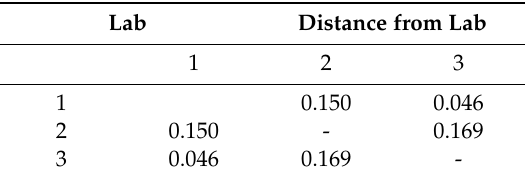
Table 1. NMR Interlaboratory